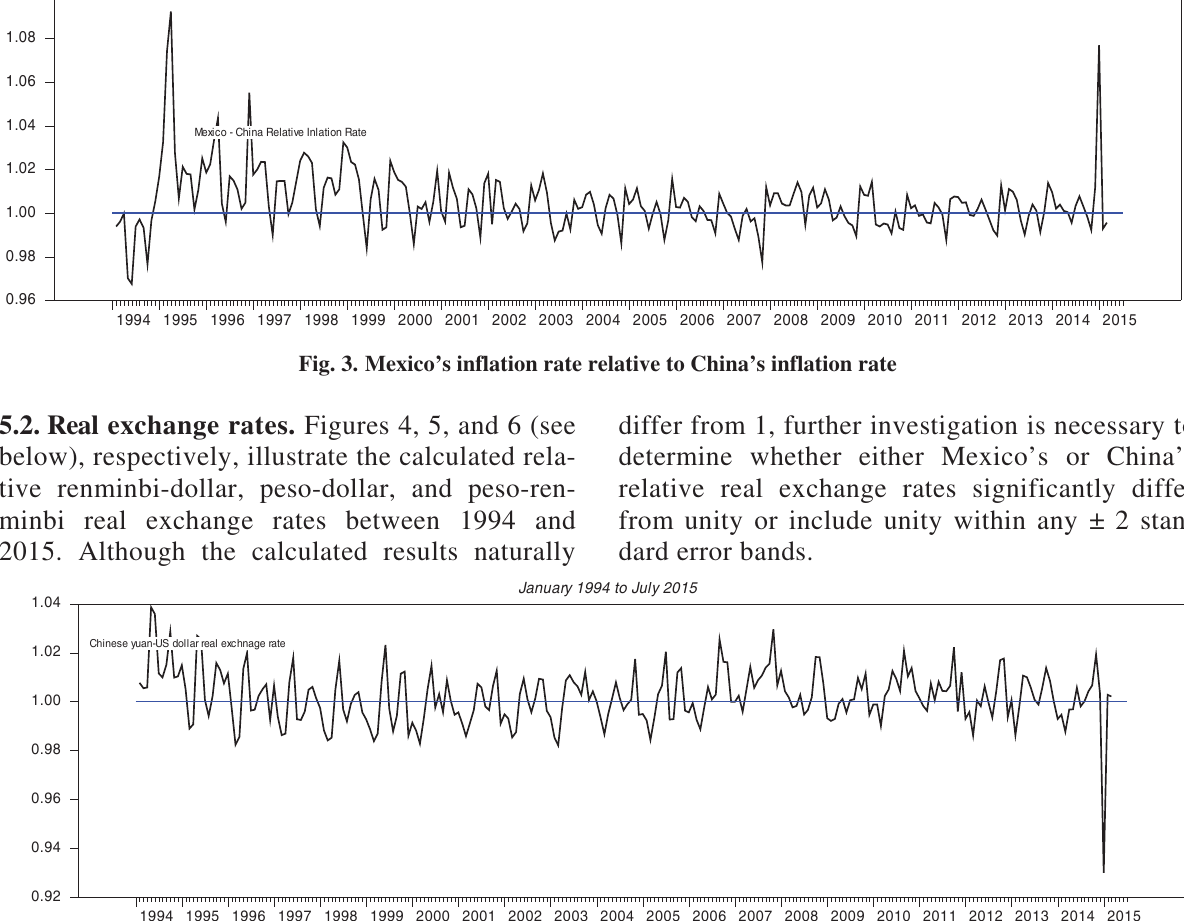
Fig. 4. Chinese yuan-U.S. dollar real exchange